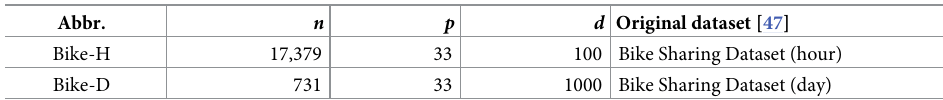
Table 5. Real-world